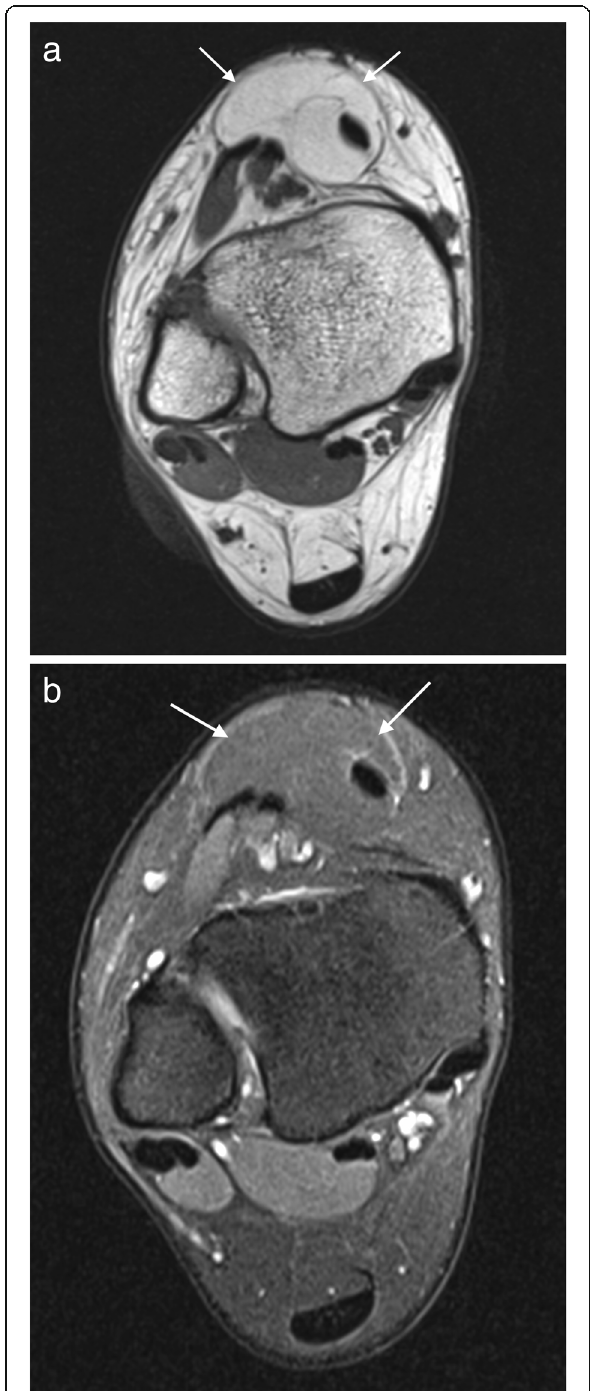
Fig. 5 Lipoma. Axial T1W ( a ) and PDFS ( b ) images of the ankle demonstrating an encapsulated lesion (arrows). The lesion is isointense to fat on T1 with uniform loss of signal on PDFS consistent with a